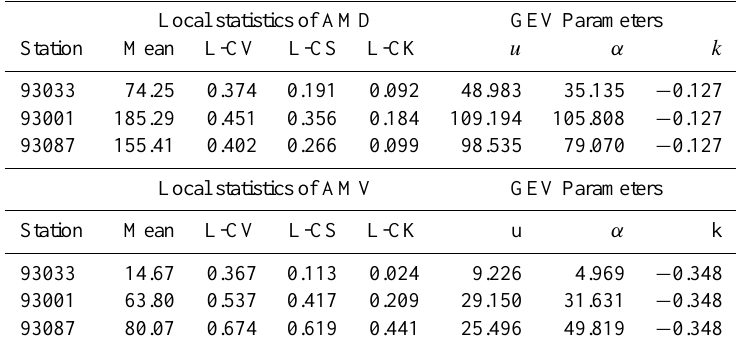
Table 2. Statistics of the AMD (m 3 /s) and the AMV (hm 3 ) series and parameters of the GEV distributions fitted with a regional shape parameter.